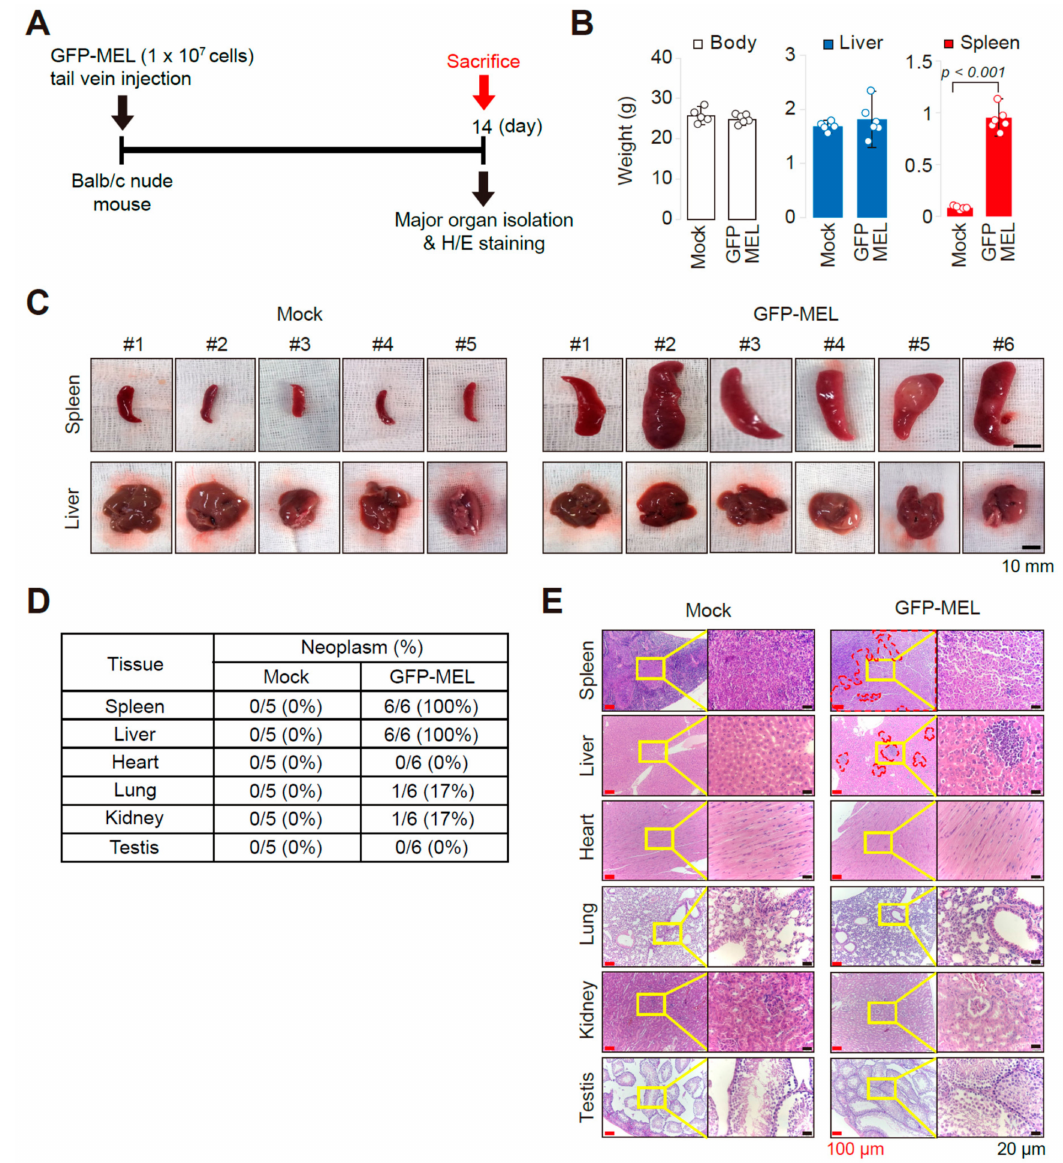
Figure 1. Establishment of an allograft mouse model using GFP-MEL cells. ( A ) Scheme of organ collection at 14 days after tail vein injection of GFP-expressing MEL cells. ( B ) Evaluating splenomegaly by quantification of body, spleen, and liver weight of each group of mice. Mock (transfused with phosphate bu ff ered saline), n = 5; GFP-MEL, n = 6. p < 0.001 by one-tailed t -test to corresponding mock-treated group. ( C ) Photographs of spleens and livers dissected out from the mock (left; n = 5) and GFP-MEL cells transfused mice (right; n = 6) at 14 days after systemic injection. ( D ) Neoplasm (erythroleukemia) incidences in the major organs of mice. ( E ) Photographs showing representative H / E-stained tissue sections for the major organs, with highly magnified images of yellow square areas. Regions with red dot spots indicate lesions with transfused GFP-MEL cells in the liver and